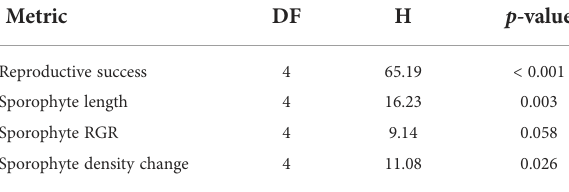
TABLE 2 Summary of Kruskal-Wallis rank sum test of differences in sporophyte measurements (reproductive success (number of